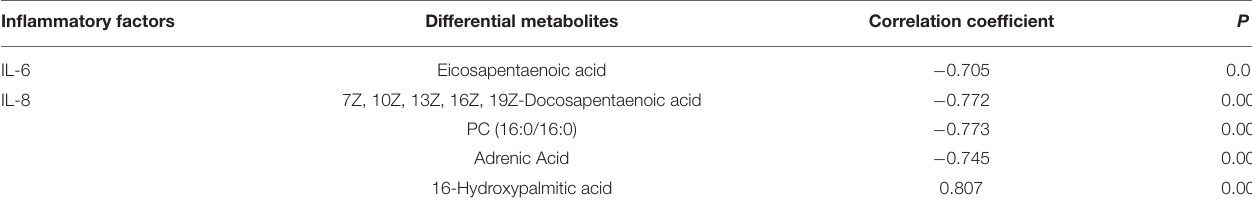
TABLE 7 | Multiple linear regression analysis of the relationships among differential metabolites and inflammatory factors. Inflammatory factors Differential metabolites Correlation